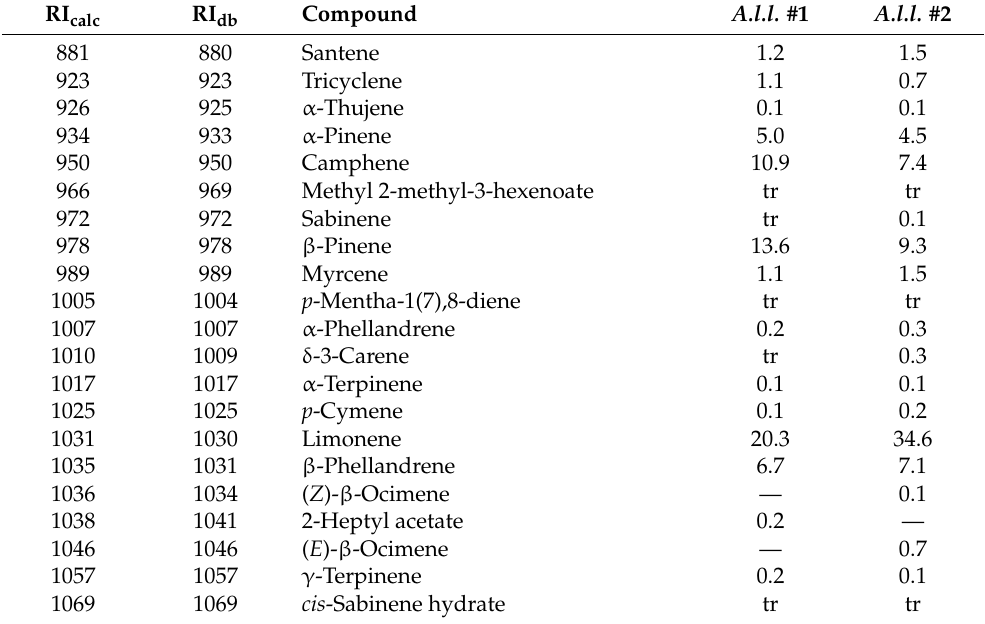
Table 1. Chemical compositions (percent) of the foliar essential oils of Abies lasiocarpa var. lasiocarpa (Rocky Mountain subalpine fir) from southern Idaho.